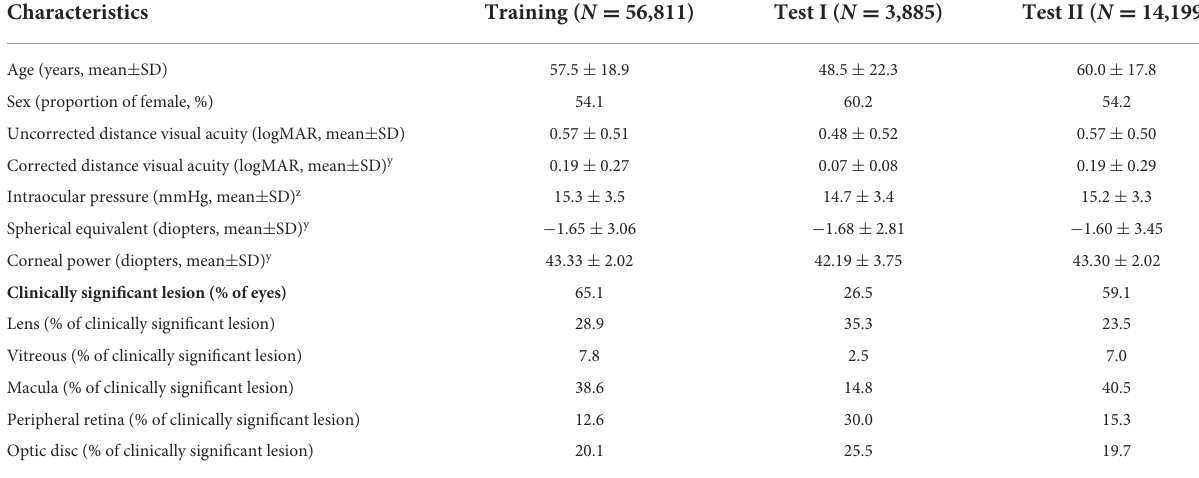
TABLE 1 Characteristics of study patients in training dataset and test dataset I and II. Characteristics